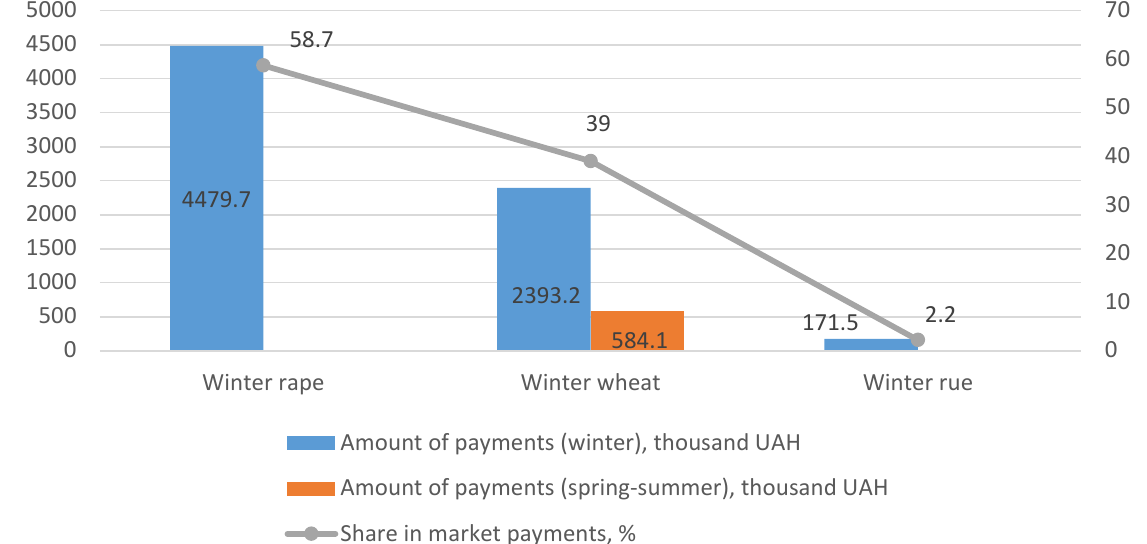
Figure 4. Insurance payments in the context of agricultural crops and seasonal gradation, 2017